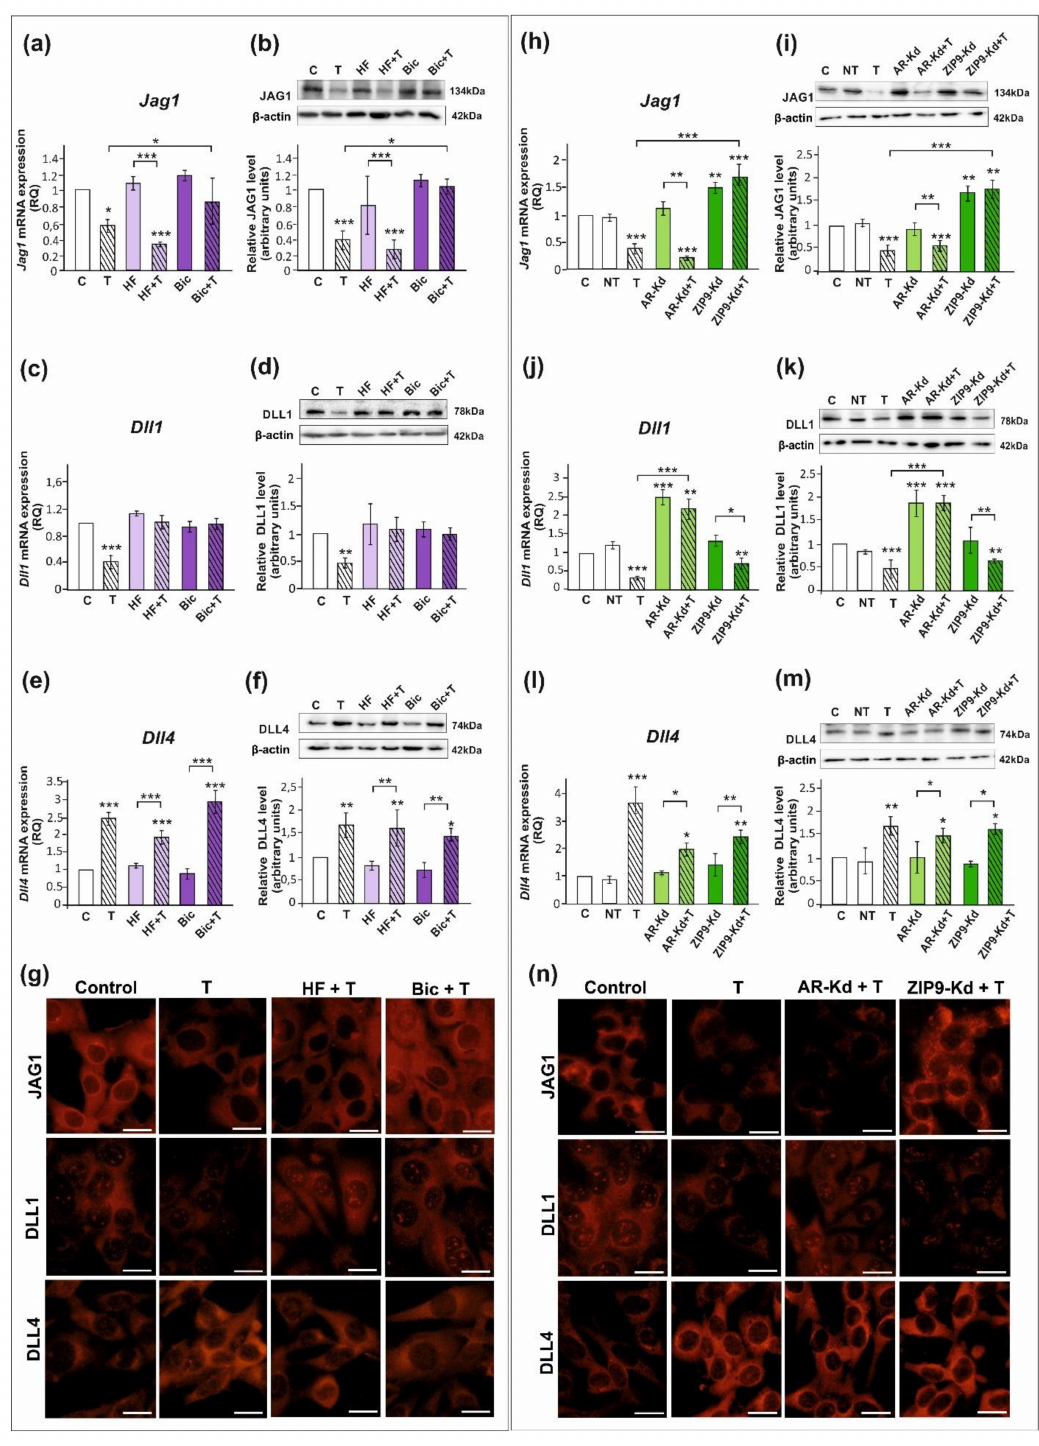
Figure 2. The effect of androgen receptor antagonists or androgen receptor silencing on mRNA and protein expression of Jag1 /JAG1, Dll1 /DLL1, and Dll4 /DLL4 in TM4 Sertoli cell line. ( a – g )